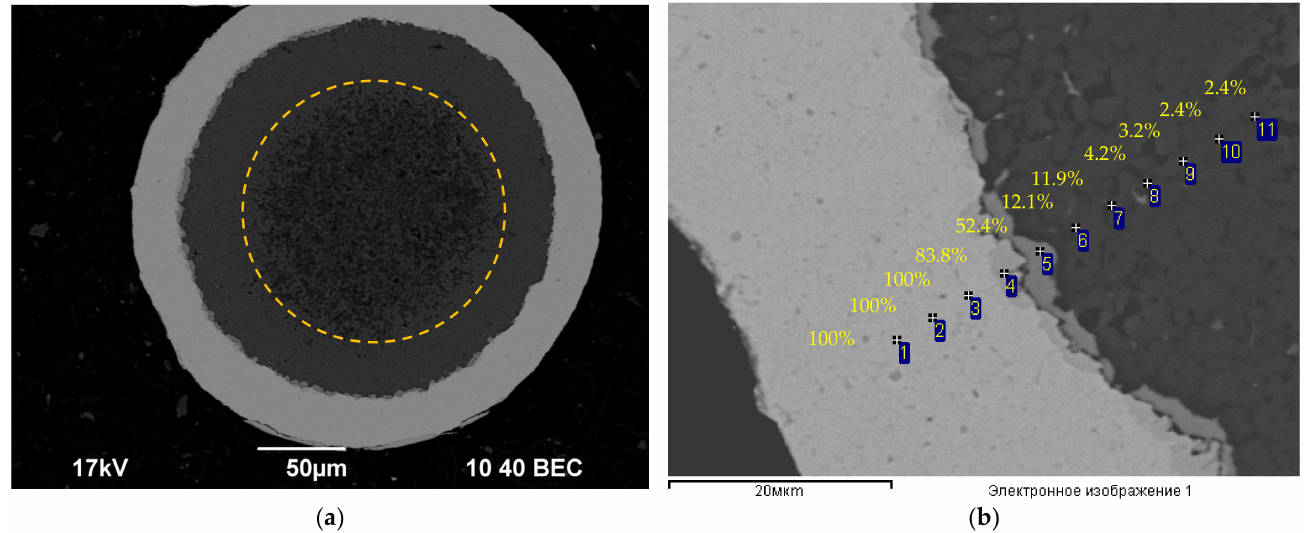
Figure 13. Macro- ( a ) and micro-structure ( b ) of a cross-section of the wire that was made from Alloy #1 and annealed at 500 ◦ C for 30 min. The numbers in Figure 13b denote the Cu concentration (in wt.%) according to the EDS microanalysis (Al–balance).